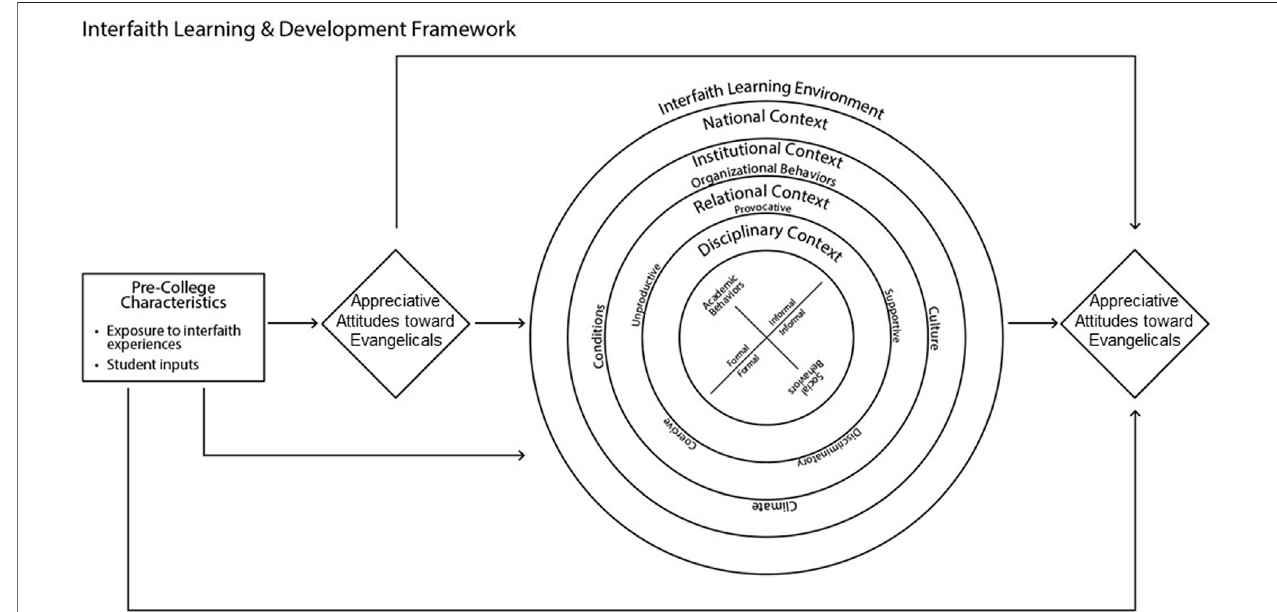
FIGURE 1 | Interfaith learning and development framework.